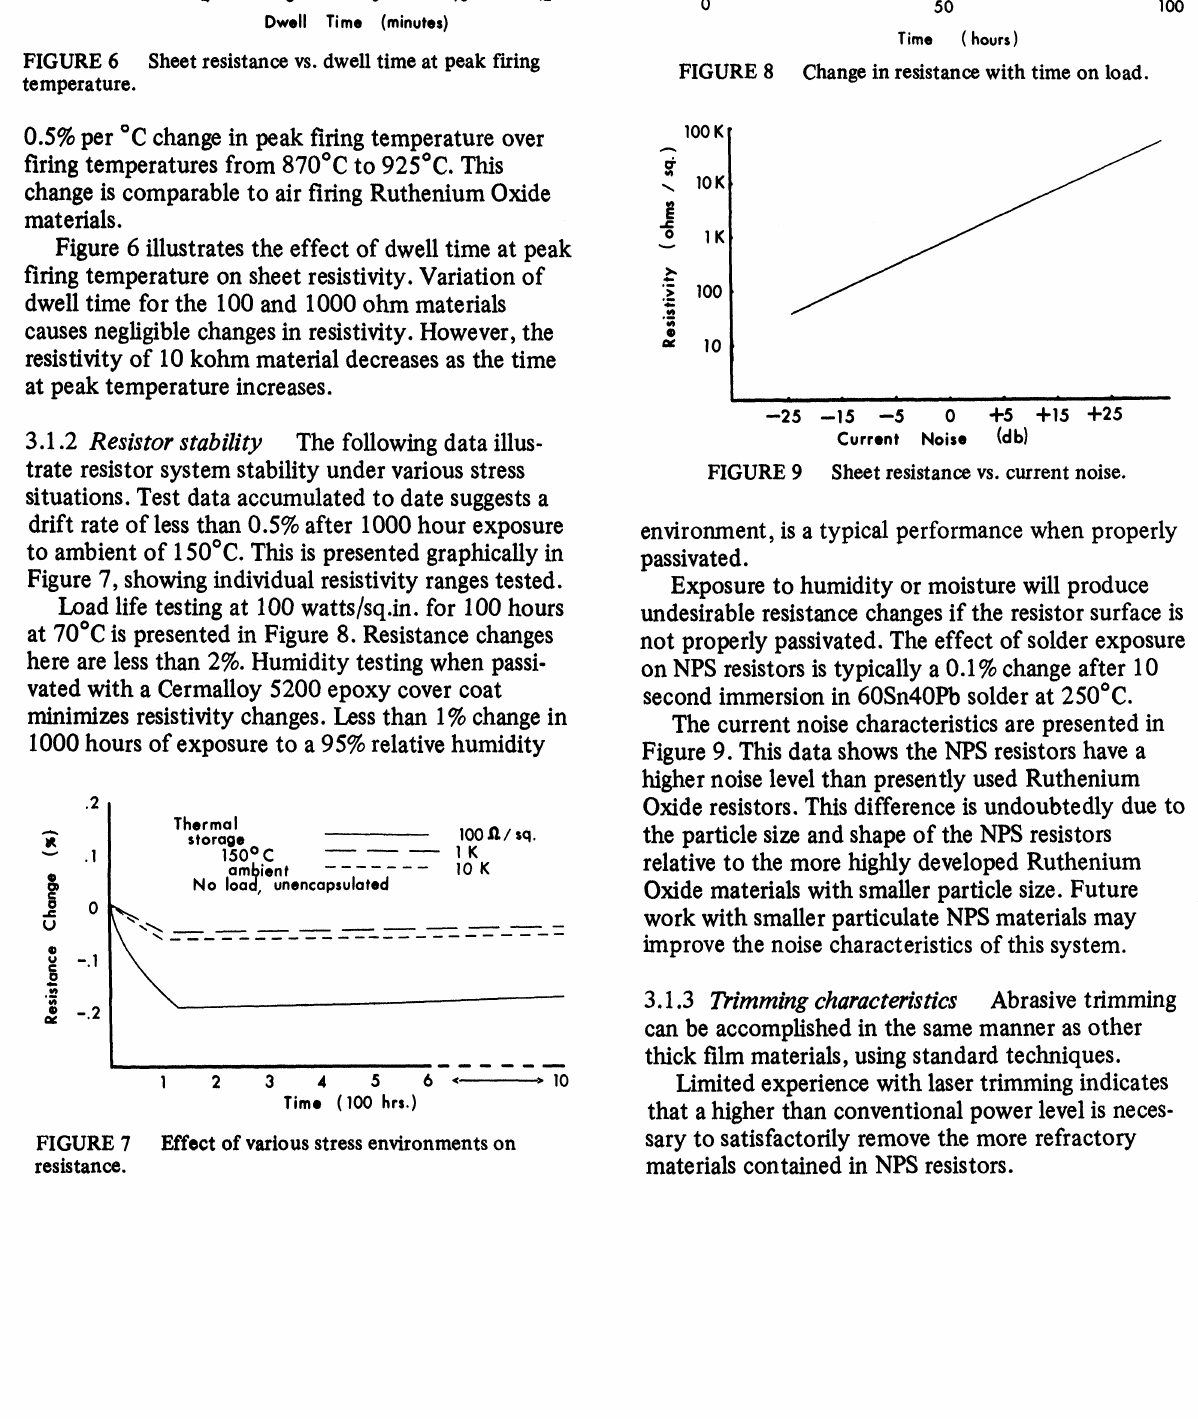
FIGURE 8 Change in resistance with time on load.